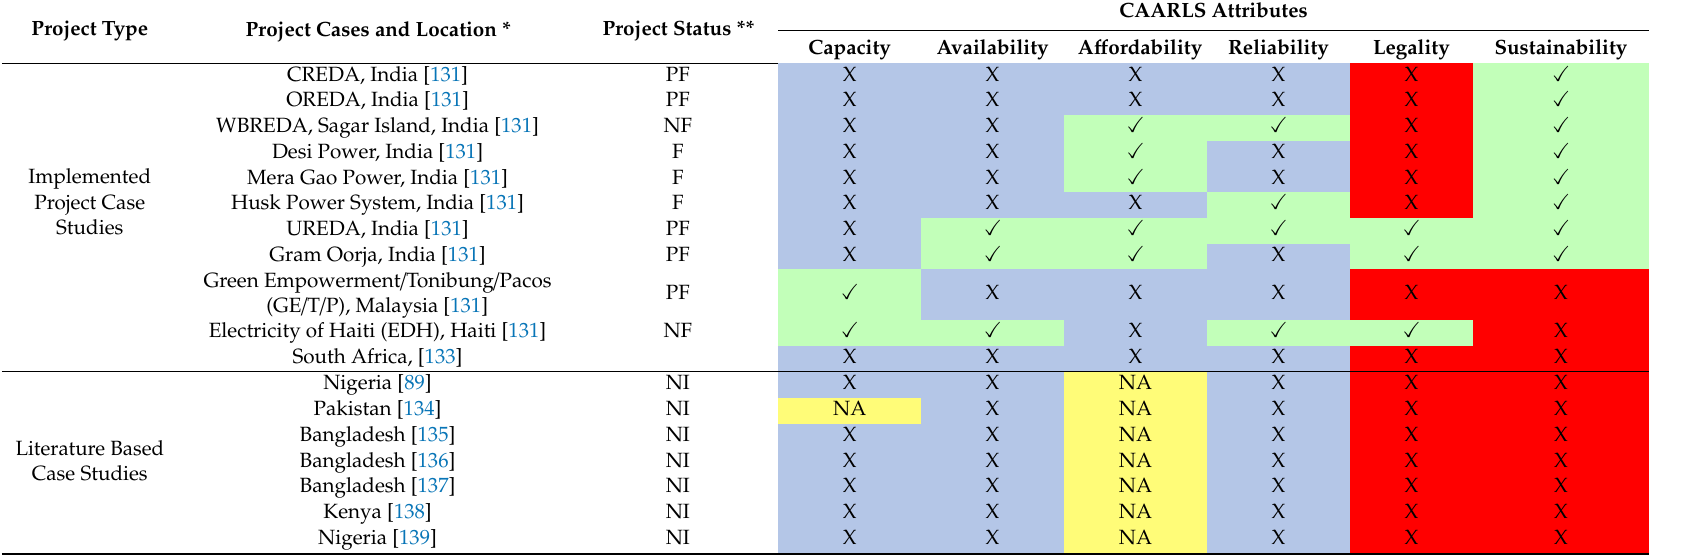
Table 5. Compliance level and attribute scorecard for the remote microgrid case studies based on CAARLS attributes.